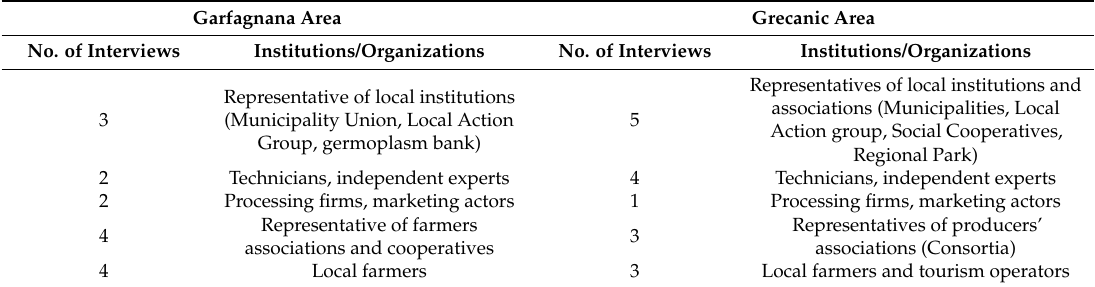
Table 1. The semi-structured interviews with local stakeholders in the case study